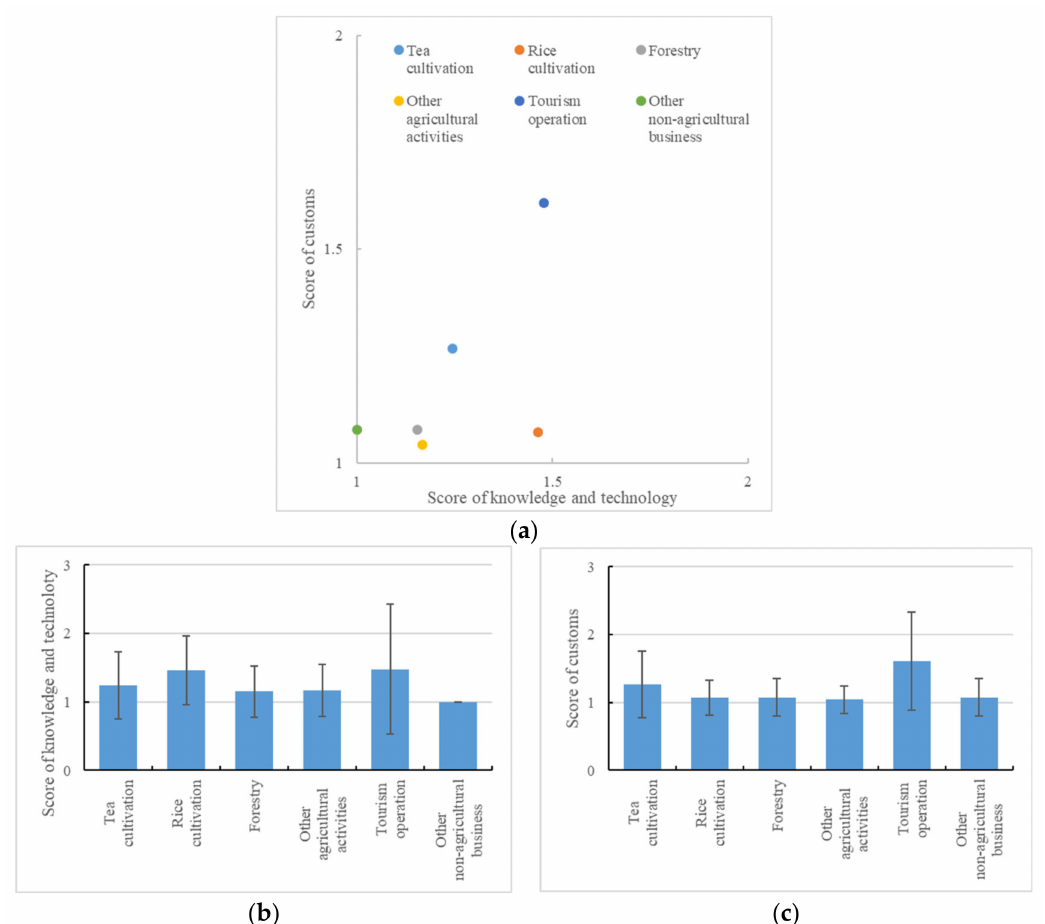
Figure 7. Recognition of traditional culture among households of different livelihood strategies. The relationship between the two factors of cultural inheritance ( a ); understanding and mastering traditional knowledge and technology ( b ); understanding and practicing customs ( c